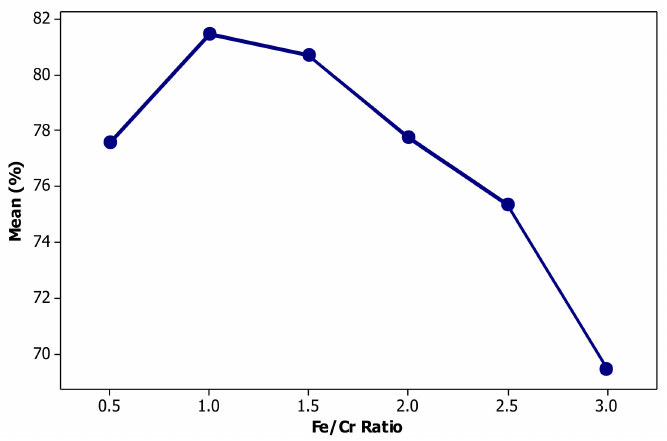
Figure 12. Effect of iron concentration on the performance of chromium